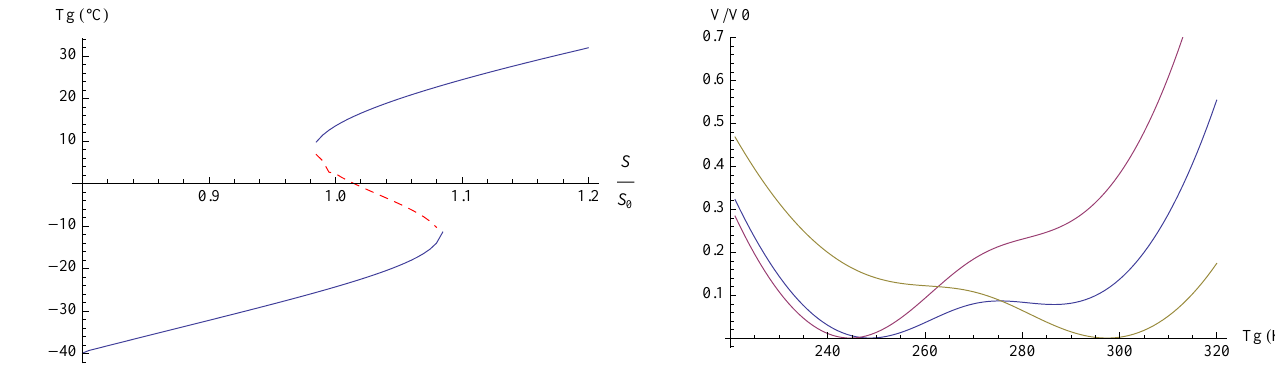
Fig. 6. Potential V (normalized) as a function of temperature T g (in K) for three different values of the solar constant: 0.95 S 0 (red), S 0 (blue) and 1.1 S 0 (yellow). For the present value of the solar con- stant, the potential has a double well shape, with two stable equi- libria, while for the two other values, the potential has only one